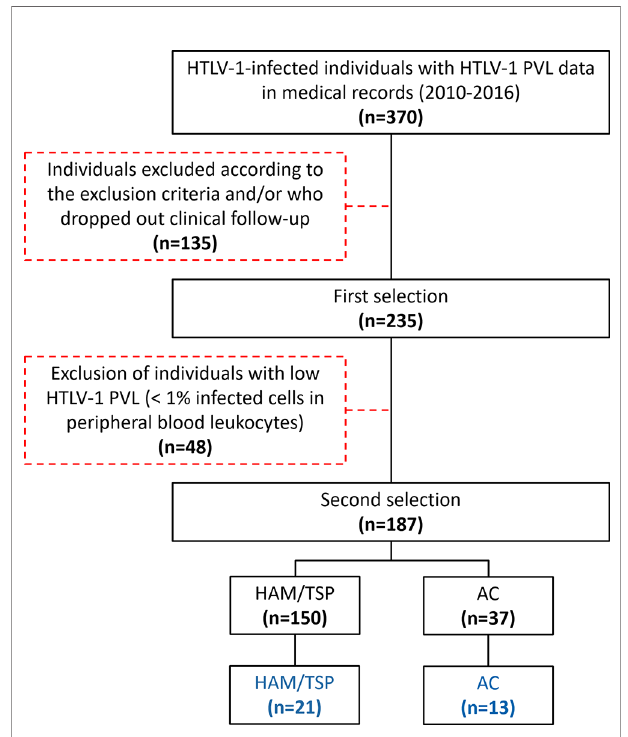
FIGURE 1 | Selection andrecruitment of thestudy population. Patients with HTLV-1 PVL recordswere accounted and individualsful fi lling the inclusion criteria andonactive clinicalfollow-up were selected.Then, individualswith HTLV-1 PVL < 1% in peripheral bloodleukocytes were excluded.Uponrecruiting, 21 HAM/ TSP patients and 13 AC agreed to participate inthe study.